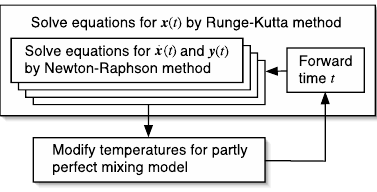
Figure 2. Numerical solution method.